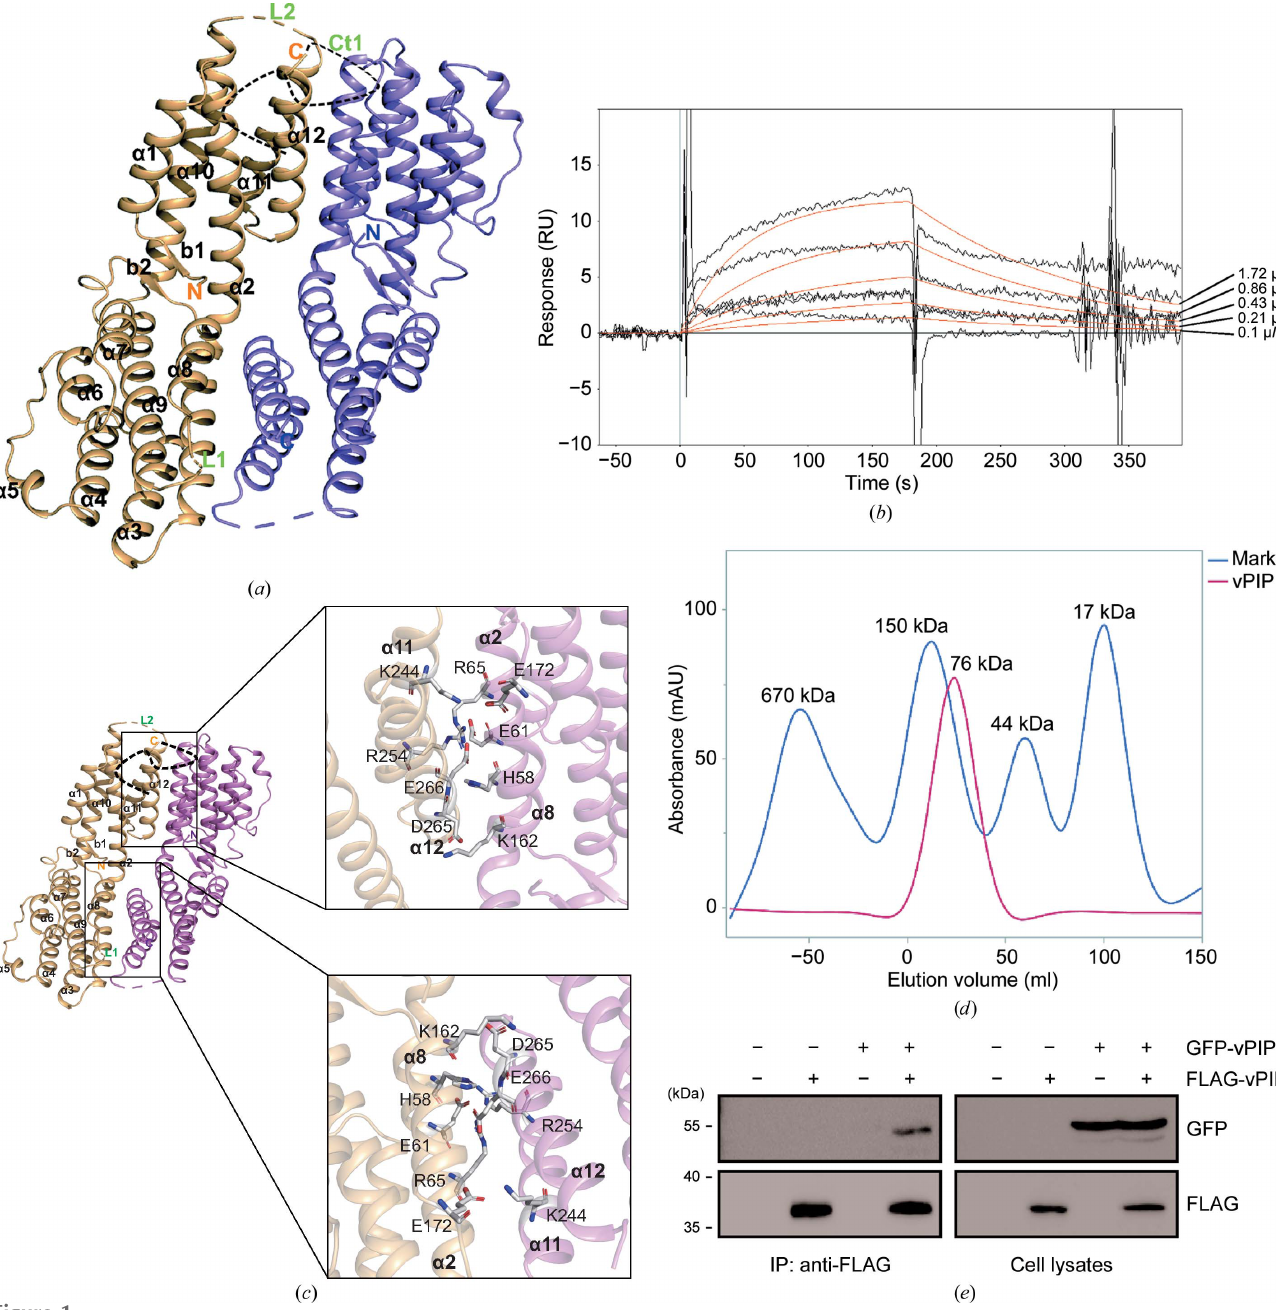
Figure 1 Overall structure and characterization of MHV-68 vPIP. ( a ) Crystal structure representation of MHV-68 vPIP. vPIP forms a dimer in the asymmetric unit with space group P 3 2 21. The crystal structure is shown with secondary structure that includes 12 (cid:2) -helices and two (cid:3) -strands. The dotted lines indicate the disordered loops (L1, L2 and Ct1). The chain A helix bundle is shown in light orange and the chain B helix bundle is shown in violet. ( b ) SPR analysis of vPIP with PARP-1. The vPIP protein was injected at five concentrations (1.72, 0.86, 0.43, 0.21 and 0.1 m M ). Dissociation data were collected for 120 s. Black lines show the actual data; the orange lines are curve fits. ( c ) A structural model of the dimer interface of vPIP. Residues in the dimer interface are presented as stick models. In the upper and lower panels each residue in chain A (His58, Glu61, Arg65, Lys162, Glu172, Lys244, Arg254, Asp265 and Glu266) and in chain B (His58, Glu61, Arg65, Lys162, Arg72, Glu172, Lys244, Arg254, Asp265 and Glu266) involved in hydrogen bonds and salt bridges is indicated. The interaction of residues was calculated using PISA . ( d ) Multi-angle light-scattering and refractive-index curves for vPIP dimerization. Light scattering (LS) is shown in blue and the differential refractive index (dRI) is shown in red. The buffer was removed and the LS and refractive index were measured and plotted against the protein sample. ( e ) GFP-tagged vPIP and FLAG-tagged vPIP were transfected into HEK293T cells for 48 h. The cells were harvested and subjected to co-IP assays using anti-FLAG. The results were analyzed by Western